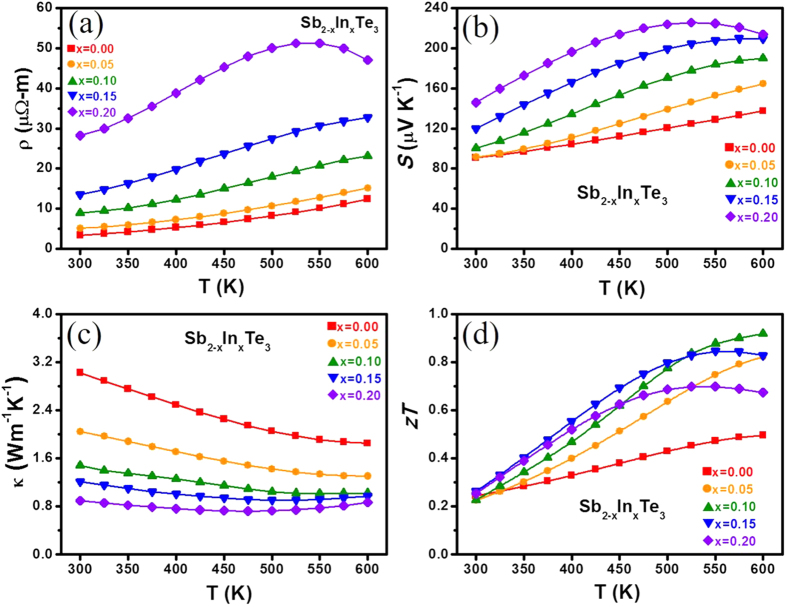
Temperature dependence of (a) electrical resistivity (b) Seebeck coefficient (c) thermal conductivity and (d) zT of Sb2−xInxTe3 for x = 0–0.2.